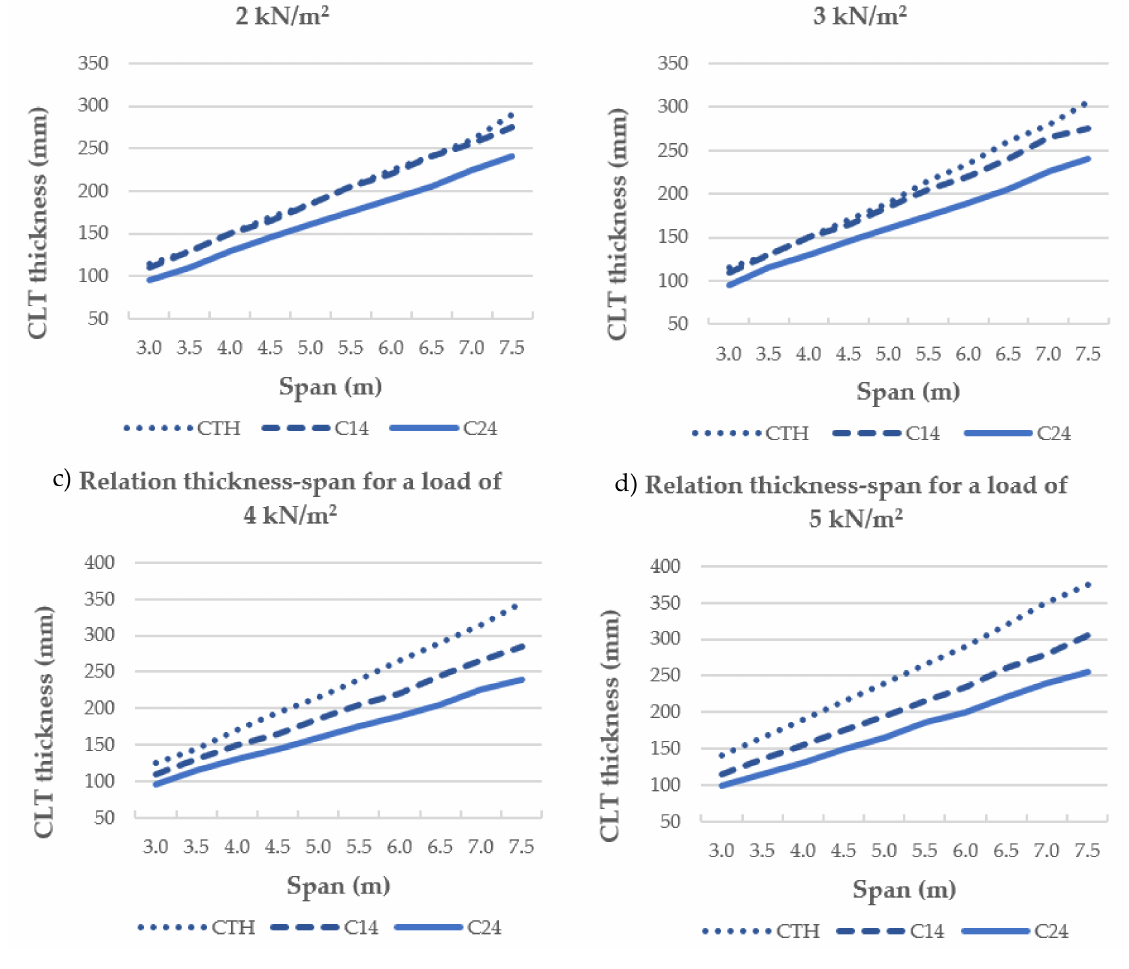
Figure 7. Relation thickness–span in the 5-layer CLT for different strength classes: ( a ) imposed load = 2 kN/m 2 , ( b ) imposed load = 3 kN/m 2 , ( c ) imposed load = 4 kN/m 2 , and ( d ) imposed load = 5 kN/m 2